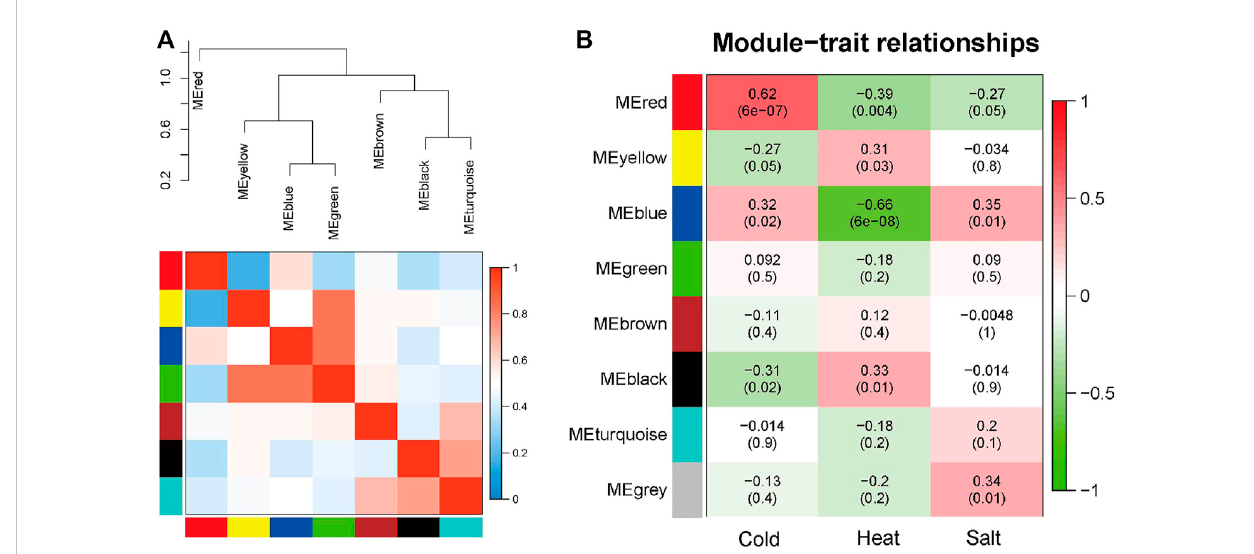
FIGURE 3 Hierarchical clustering dendrogram of module eigengenes and heatmap plot of the adjacencies in the eigengene network (labeled by their colors). (A) In the heatmap, the green color represents low adjacency (negative correlation), while a red represents high adjacency (positive correlation). (B) Correlation between sample grouping and gene modules. Each row of the table corresponds to a gene module, and each column corresponds to a